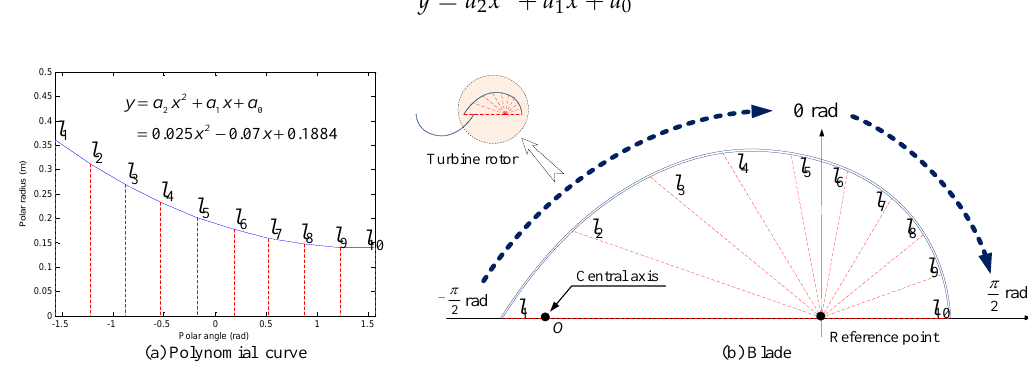
Figure 1. Polynomial curve and the corresponding blade.